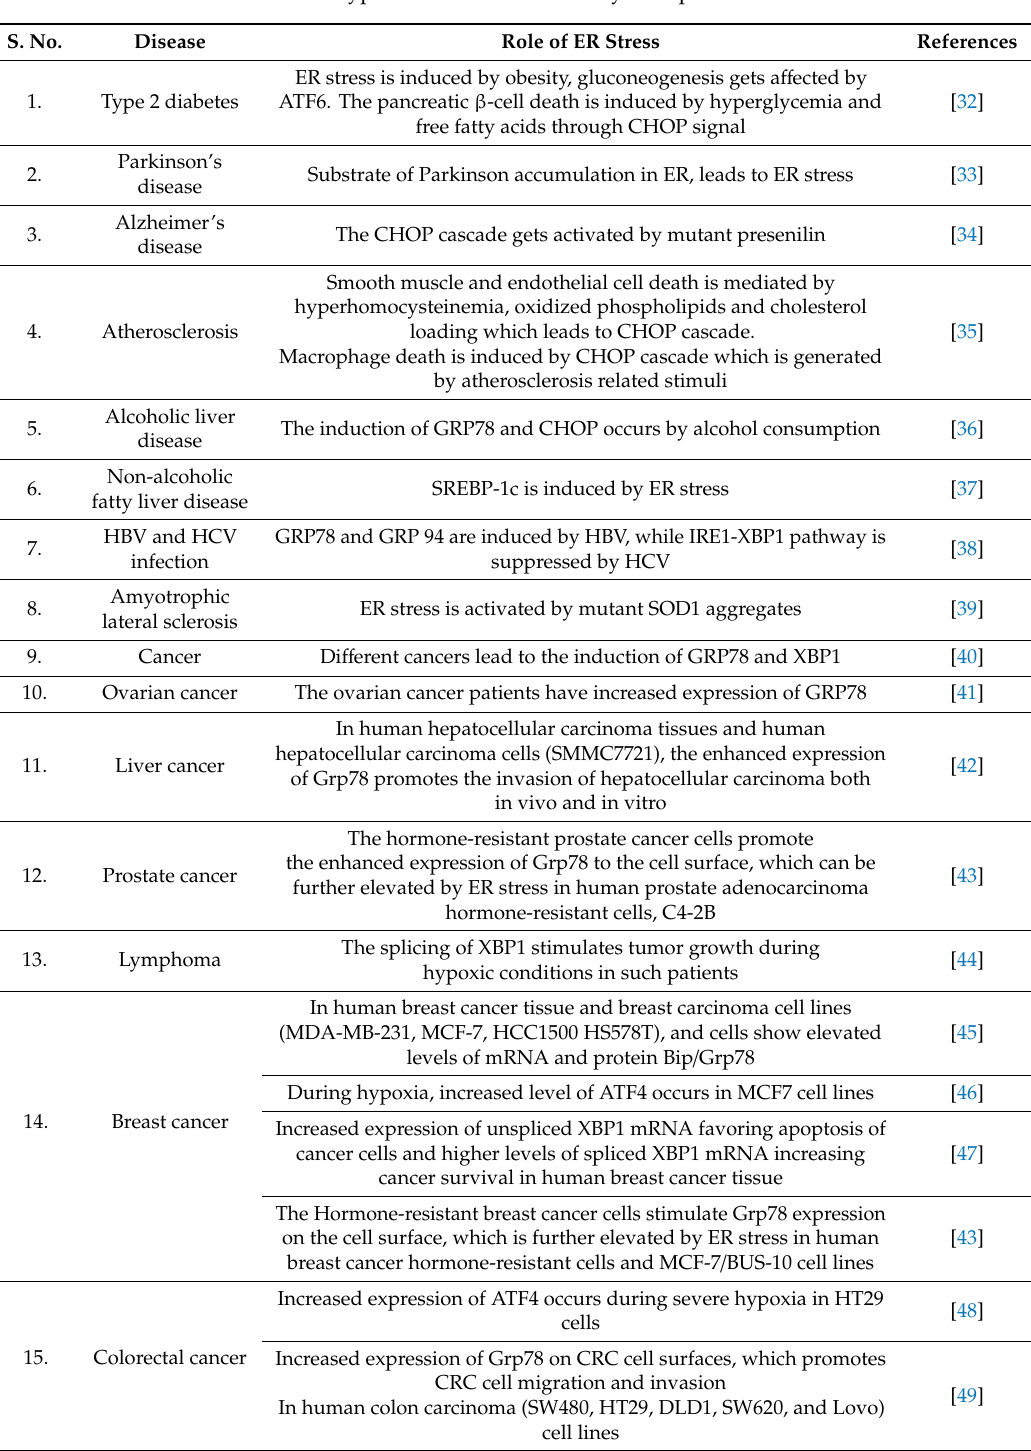
Table 1. Some common types of diseases induced by endoplasmic reticulum stress. S.